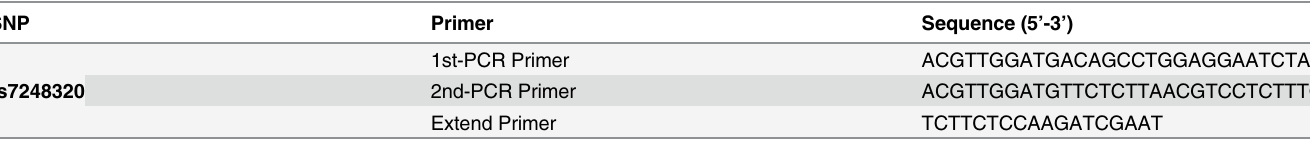
Table 1. Information of primers for Sequenom MassARRAY Iplex.